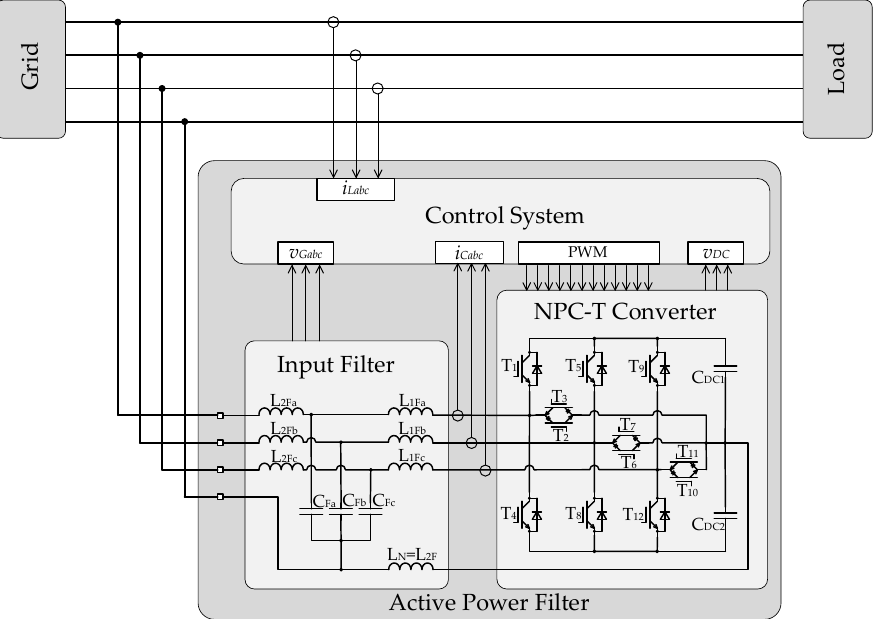
Figure 6. Topology of the proposed active power filter.